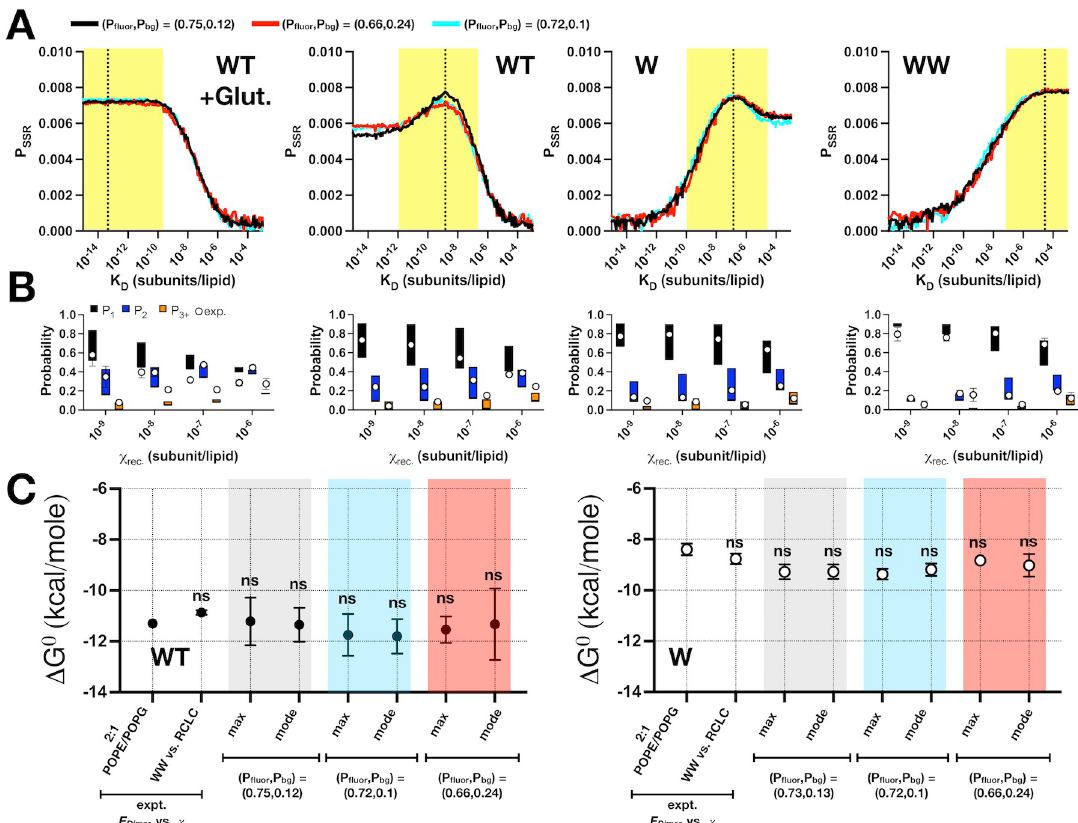
Fig 4. Estimating K D values for CLC-ec1 dimerization in membranes. (A) P SSR for dimeric glutaraldehyde cross-linked WT, reactive . Curves reflect WT, reactive I422W, ’W’, and monomeric I201W/I422W, ’WW’, as a function of the dissociation constant parameter K D the model using the experimental labeling parameters (P fluor , P bg ) expt . —black or the R230C/L249C fitted labeling parameters (P fluor , P bg ) max —cyan, (P fluor , P bg ) boot . − red. Dotted line represents the maximum P SSR value and best-fit K D using the (P fluor , P bg ) max labeling parameters, and the yellow box reflects the uncertainty based on the bootstrapping analysis. (B) Range of photobleaching probability distribution ( P 1 , P 2 , P 3+ ) simulated using (P fluor , P bg ) max and K D , boot . —σ , K D , boot . , K D , boot . + σ and agreement with experimental data (white circles). (C) Δ G 0 for WT and W [20] based on least-squares estimation of F from expected monomer and dimer Dimer photobleaching probability distributions compared to the direct fitting of the photobleaching probability distribution while iterating ° ) , where K over K as a parameter. Δ G 0 = −RTln(K and χ ° = 1 subunit/lipid represents the mole fraction standard state. D eq χ eq = 1/K D Results shown for the best-fit, ’max’ , value as well as the mode of the bootstrapping analysis for (P fluor , P bg ) expt . —grey, compared to